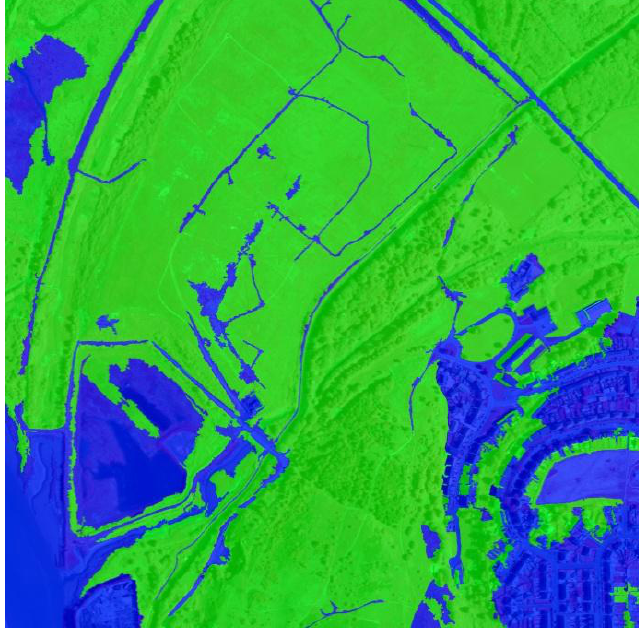
Figure 4. Output (30% transparent) of initial multiresolution segmentation process (Level 1), showing clear delineation of ‗Low‘ (blue) and ‗High NDVI‘ (green) landscape